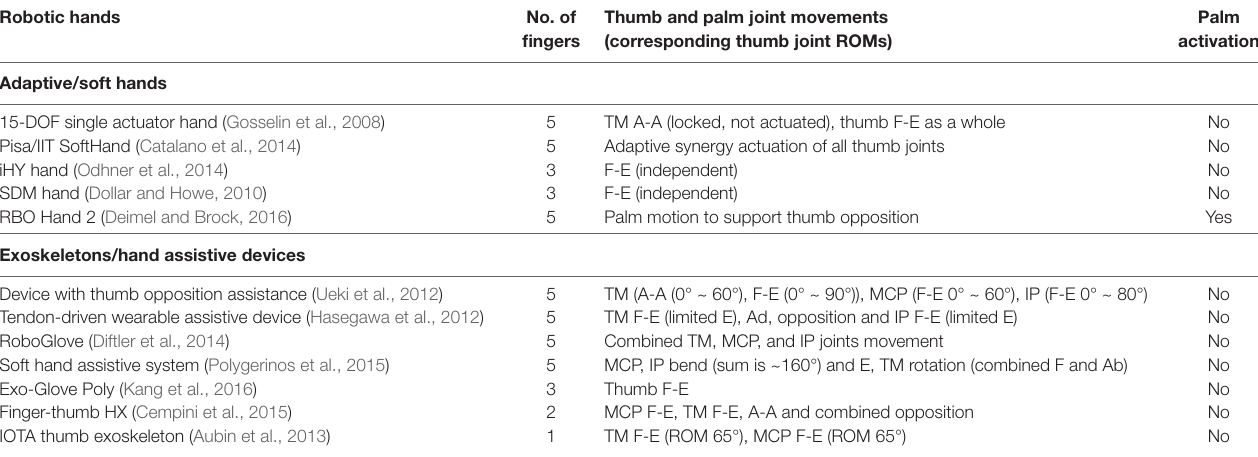
Thumb and palm joint movements fingers (corresponding thumb joint ROMs)